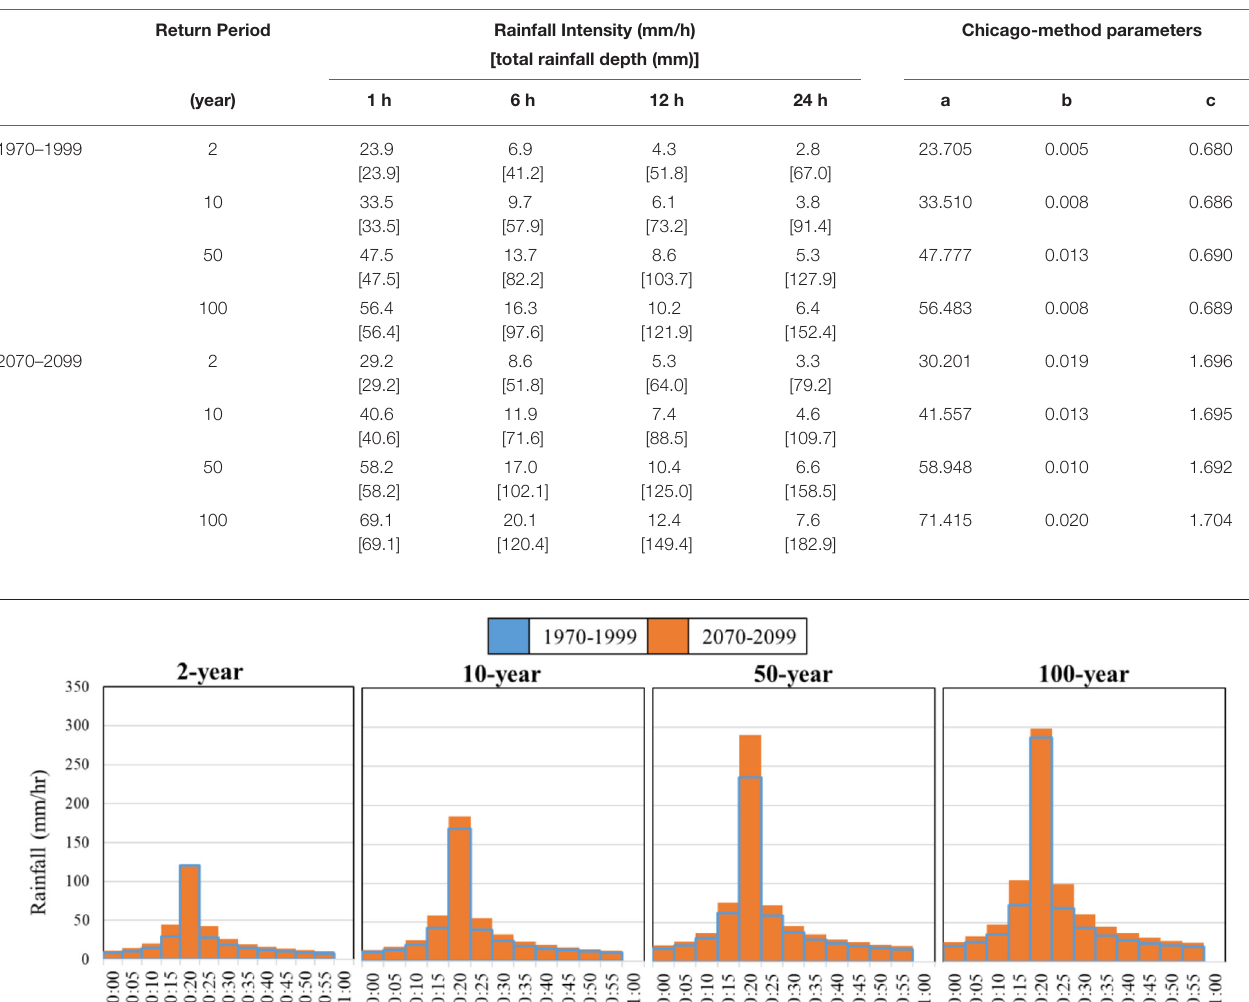
(2079–2099 w/o PP) and lower bounds (1979–1999 w/o PP), the absolute differences in CSO volumes between the current and future timeframes generally increase with the rainfall